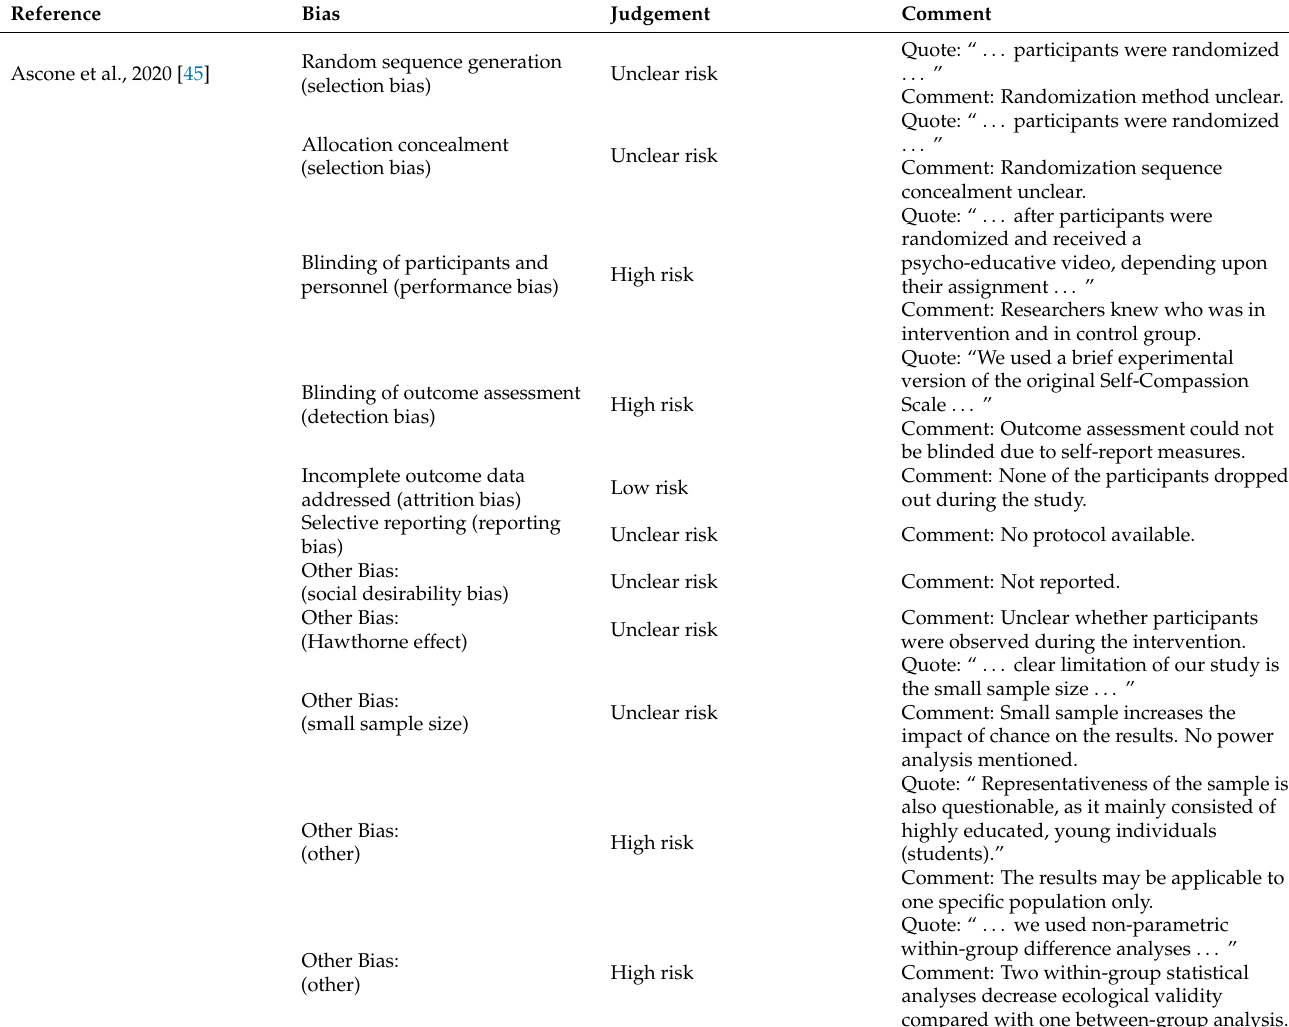
Table A2. Risk of bias analysis for the selected